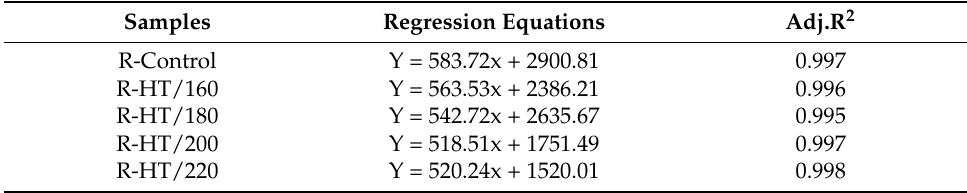
Figure 3. MCs obtained by oven-drying method versus the integral peak areas of the T 2 curves. Table 1. The regression equations obtained by linear fitting of peak area and MC for samples with water absorption in the R direction.